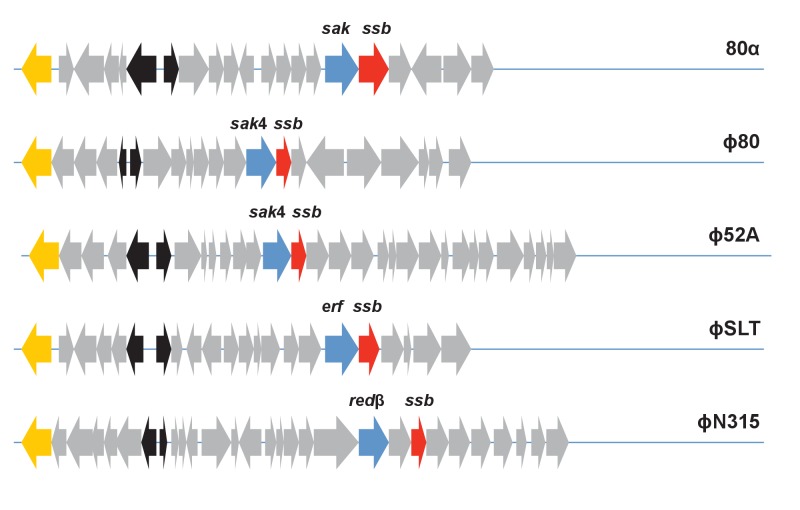
Localisation of the recombinase and ssb genes in different staphylococcal phage genomes.The 5’ regions of phages 80α (NC_009526), ϕ80 (DQ908929), ϕ52A (AY954965), ϕSLT (AB045978) and ϕN315 (NC_004740) are shown. Yellow: integrase (int); black: regulatory module; blue: ssap genes; red: ssb genes; grey: other genes.